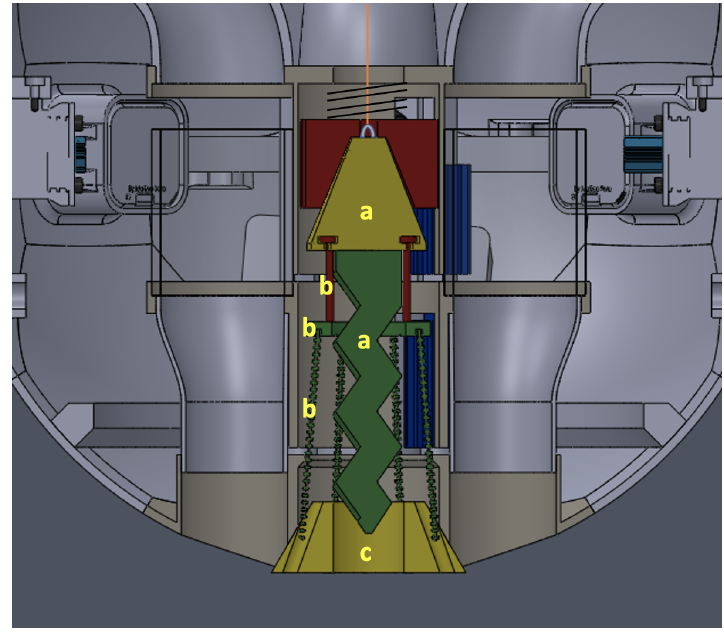
Figure 5. RAATM anchor sub-assemblies in the stowed position. The anchor assembly components are depicted in Figure 6 and labeled with red numbers.